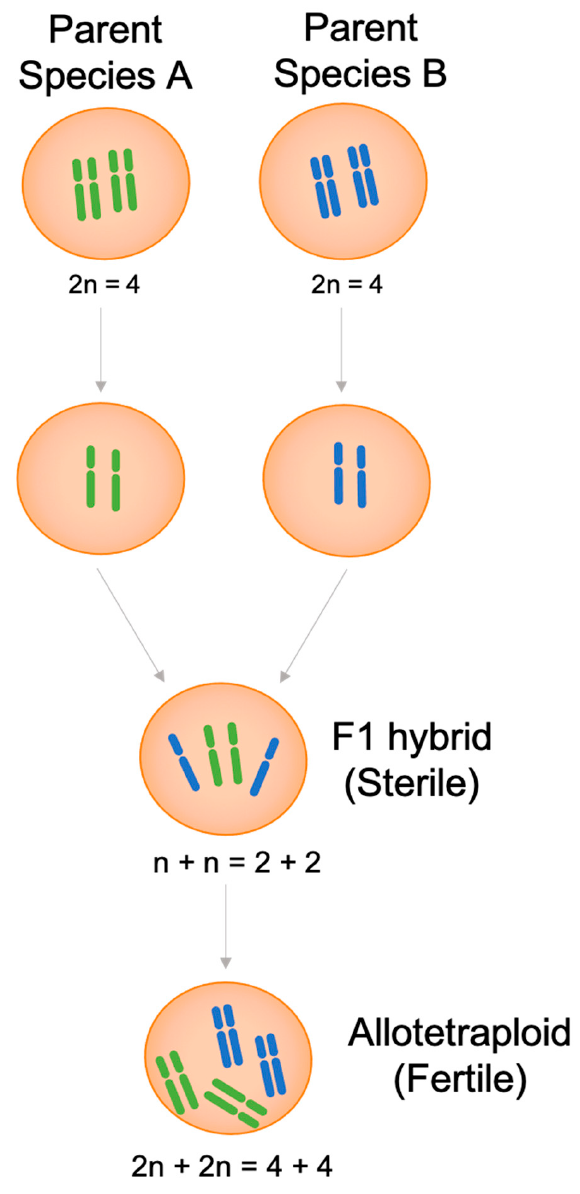
Figure 2. Type of gametes and duplication event during the formation of an allopolyploid.